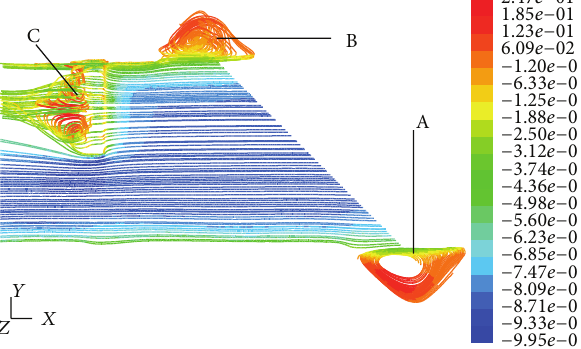
Figure 5: The diagram of sound channel ( 𝑅 𝑒 = 1168 ).